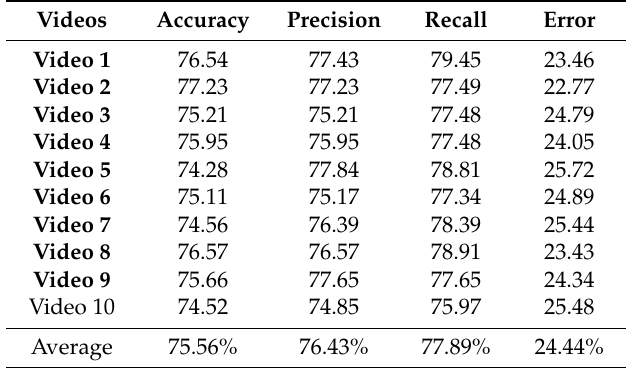
Table 8. Performance evaluation using extreme learning machine classifier with local tetra pattern